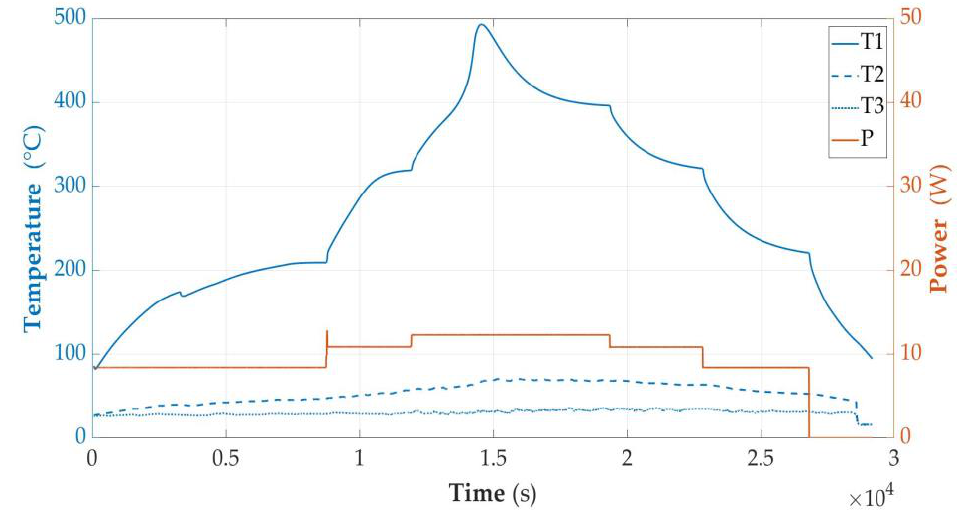
Figure 10. Graphs of temperature changes during heating and energy supplied to the cell module in the SOC < 0% state.